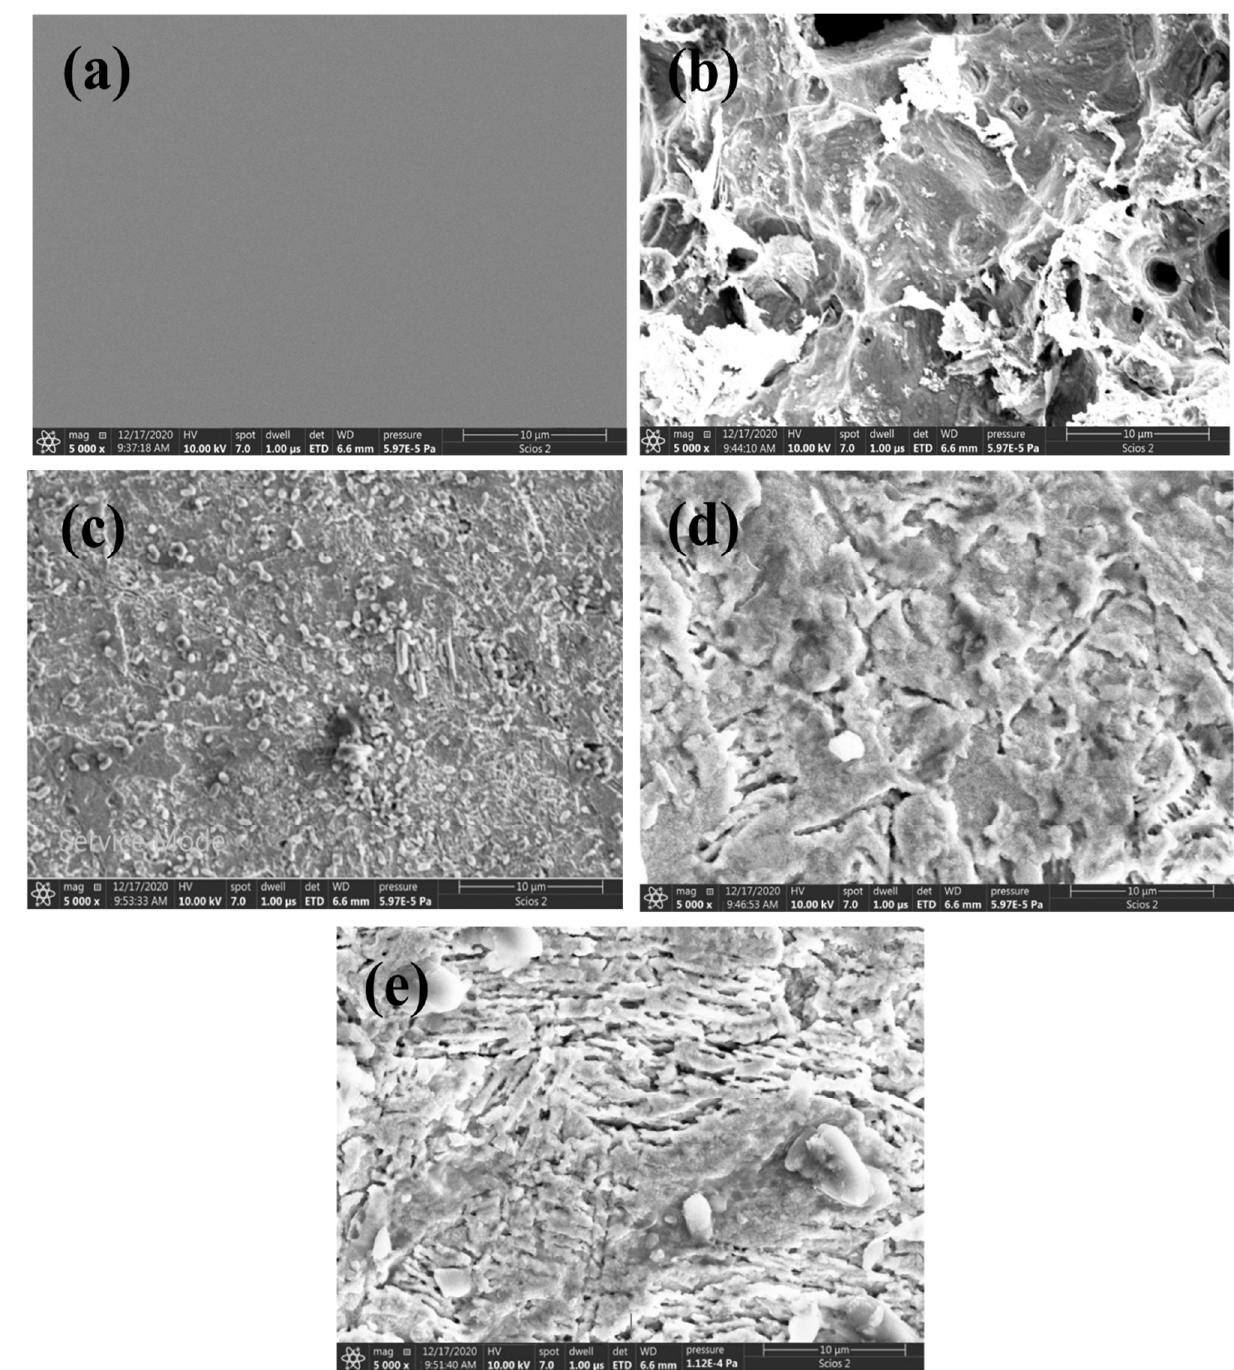
Figure 19. SEM micrographs of mild-steel surfaces; (a) prior to immersion, (b) after immersion in 0.5 M HCl solution for 24 h, (c–e) after 24 h immersion in 0.5 M HCl with 300 ppm of the examined carbohydrate polymers, Chi, Pec, and A-Pec, individually.